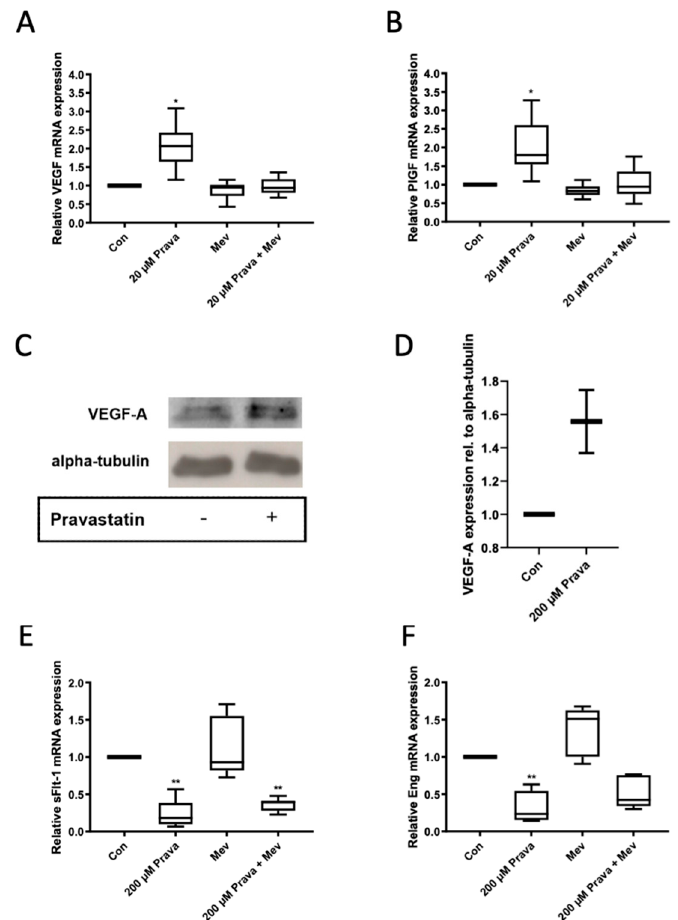
Figure 6. Pravastatin affected mRNA expression of pro-angiogenic and anti-angiogenic molecules. Pravastatin (20 µ M) significantly induced mRNA expression of pro-angiogenic molecules vascular endothelial growth factor A (VEGF-A) ( A ) and placental growth factor (PlGF) ( B ), whereas mevalonate alone had no effect. In immunoblot ( C ), treatment with pravastatin (200 µ M) increased VEGF-A protein expression ( D ). Co-treatment with mevalonate (200 µ M) reduced pravastatin induced VEGF-A and PlGF mRNA expression. mRNA expression of the anti-angiogenic molecule soluble fms-like tyrosine kinase-1 (sFlt-1) ( E ) and the angiogenesis-related protein endoglin (Eng) ( F ) was significantly reduced by pravastatin (200 µ M). Mevalonate (200 µ M) did not significantly affect sFlt-1 mRNA expression but, in combination with pravastatin, reversed the pravastatin effect on sFlt-1 mRNA expression in ECFCs. Results are from at least 3 independent runs. All runs were performed in triplicates. Con, control; Prava, pravastatin; Mev, mevalonate. * p < 0.05, ** p < 0.01; control group set as 1.